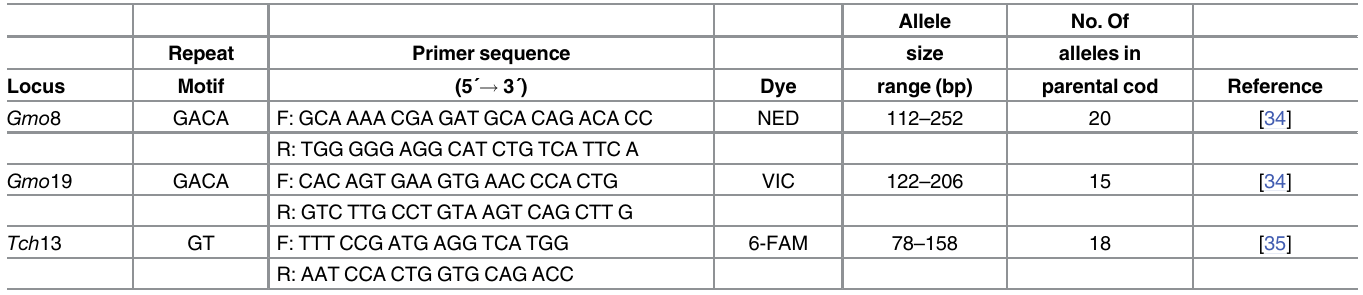
Table 2. Primer and locus information for the three microsatellite markers used.